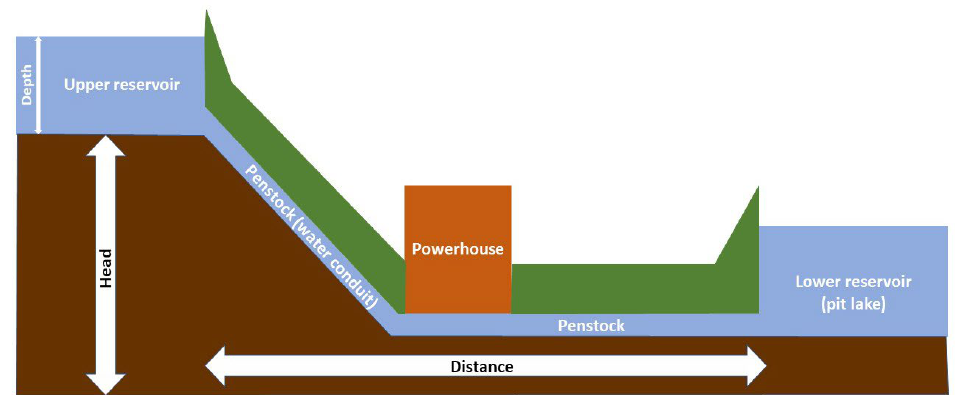
Figure 5. Schematic layout of a pumped storage plant (PSP). On the left, the hydraulic head elevation between the two reservoirs and the depth of the upper reservoir are illustrated. In addition, the distance between the two reservoirs and the length of the water conduit are depicted at the bottom and middle (modified from [36]).